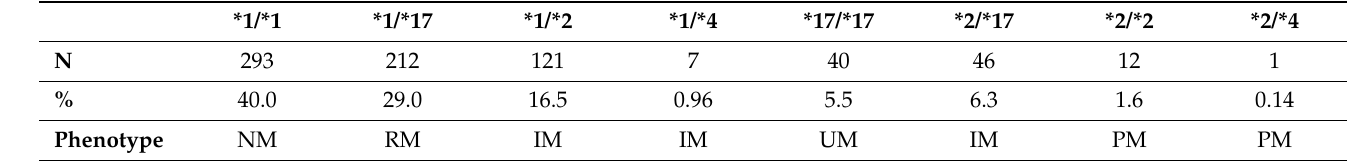
Table 2. Diplotype distribution for CYP2C19 .